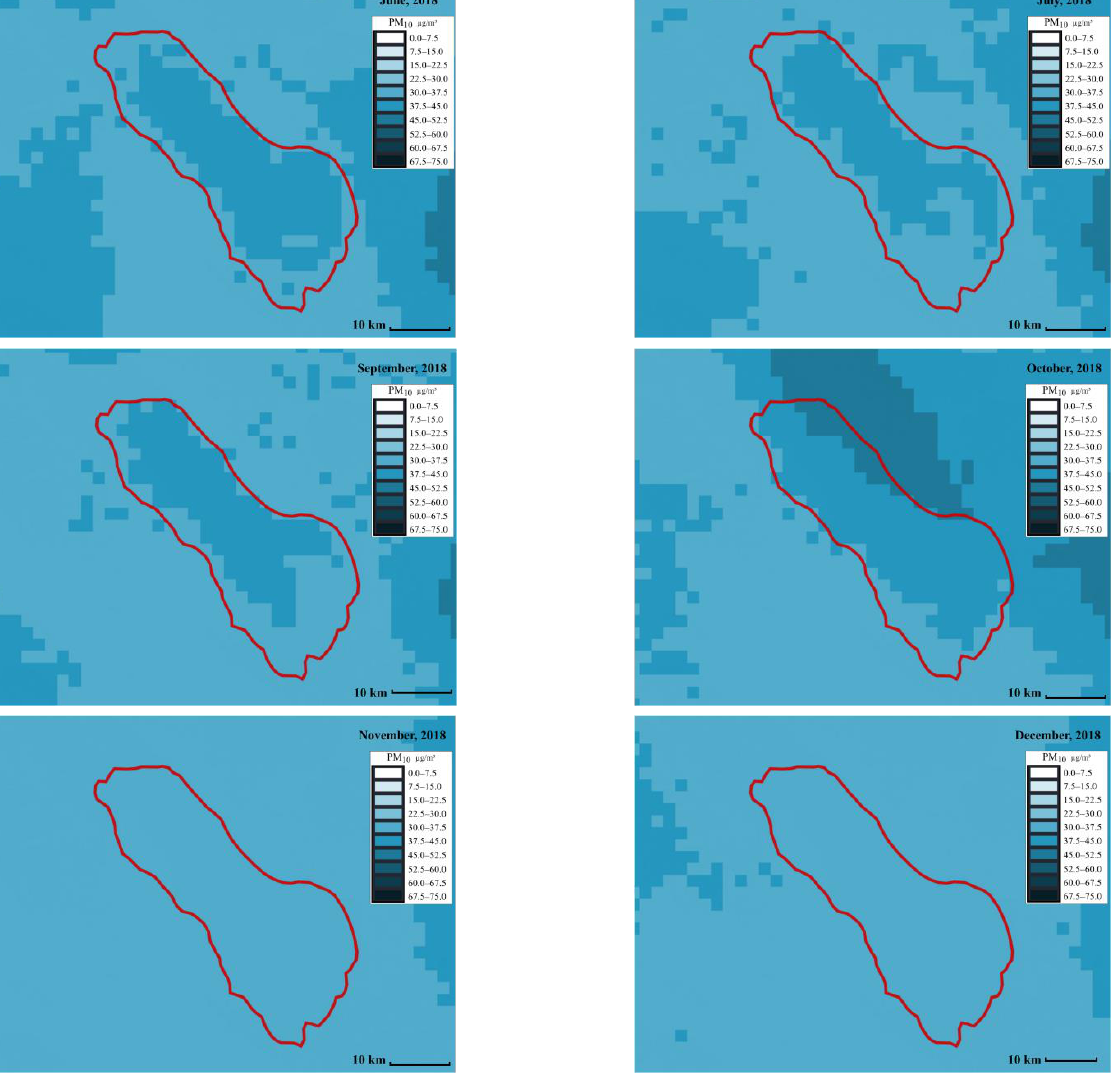
Figure 7. PM 10 map using a weighted average ensemble model in the Salton Sea area from January to December (created by author).